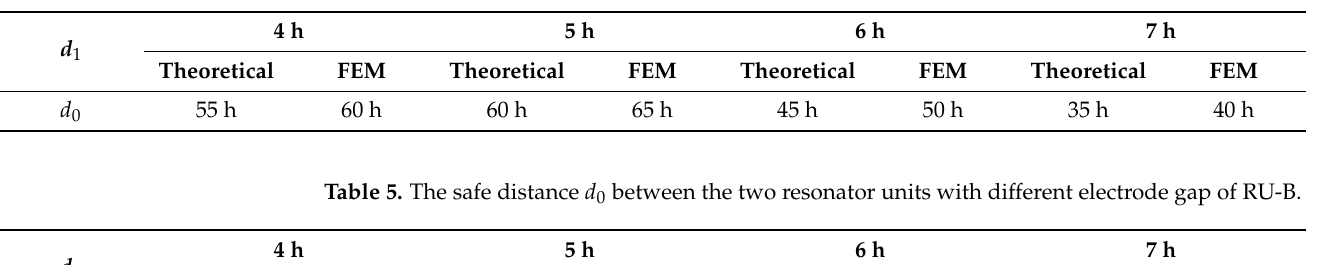
Table 5. The safe distance 0 RU-B.